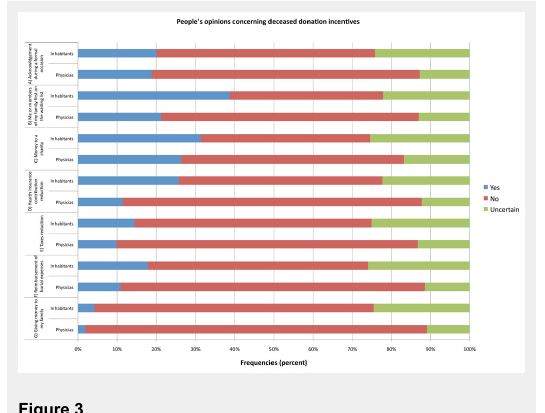
Figure 3 Distribution of the physicians’ and inhabitants’ answers to the different deceased organ donation incentive propositions. Distribution of the physicians’ and inhabitants’ answers for item